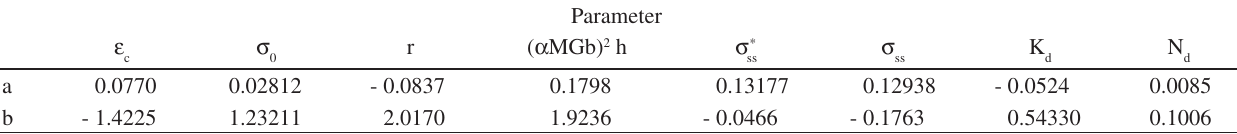
Table 5. Database for predicting 304 stainless steel flow stress curves under hot working conditions, presenting a and b parameters of Equation